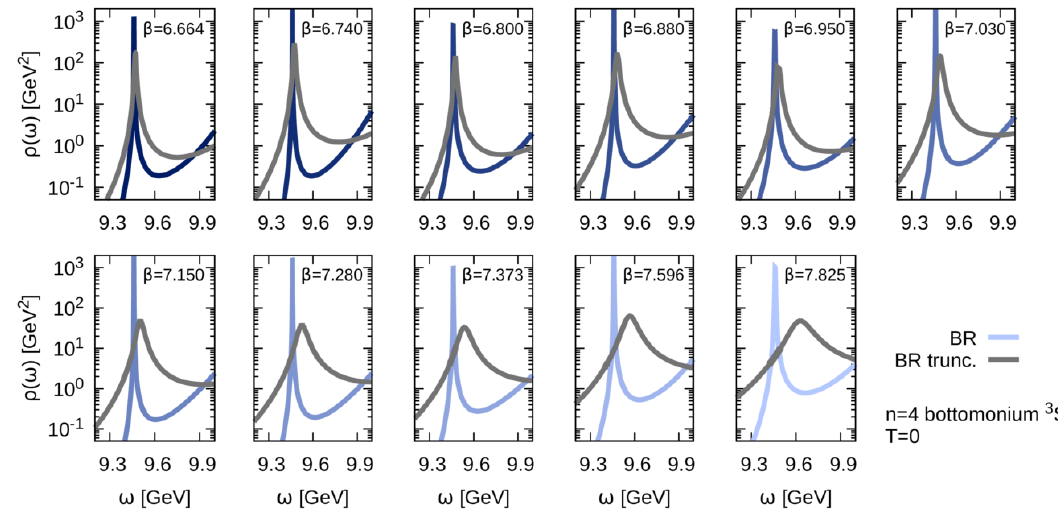
Figure 14 . Representative example of the in(cid:13)uence of truncating the low-temperature simulation data to the same (cid:28) max =a (cid:28) = 12 Euclidean time extent available at (cid:12)nite temperature. The spectra shown here correspond to the 3 S 1 channel of bottomonium with the full reconstruction given by colored solid lines, while the result after truncation is given by the gray solid curves. Clear system- atics are visible: a reduction in the input data quality leads to a shift of the reconstructed ground state peak to higher frequencies, as well as to a signi(cid:12)cant